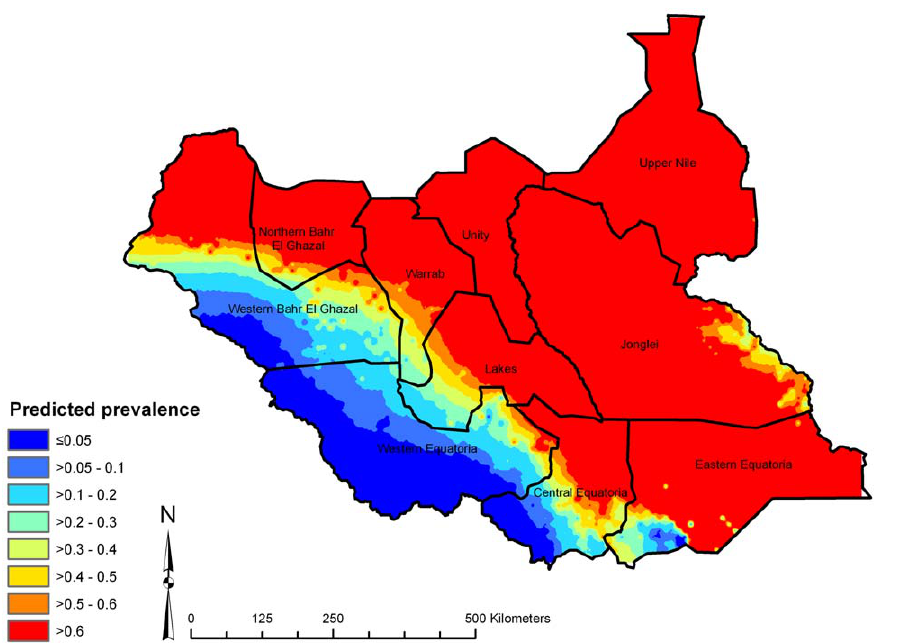
Figure 4. Upper quartile of posterior distribution of predicted prevalence of active trachoma in children aged 1–9 years, Southern Sudan, 2001–2009.